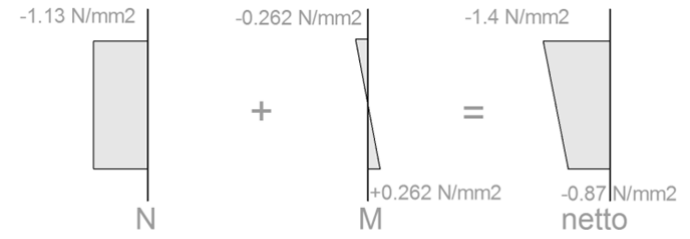
Fig. 4 Stress diagrams for the arch unevenly loaded.